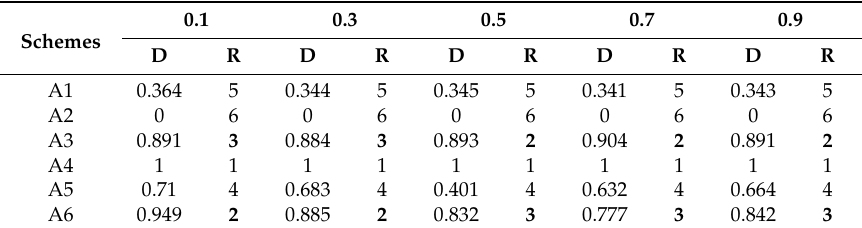
Table 12. Schemes with different subjective weight ranking